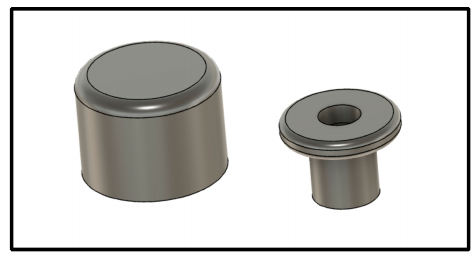
Figure 18. Updated wire management system.